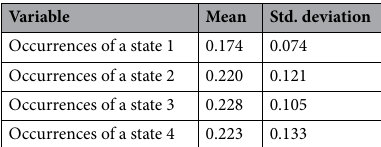
Table 1. Mean rs-dFC outcomes.